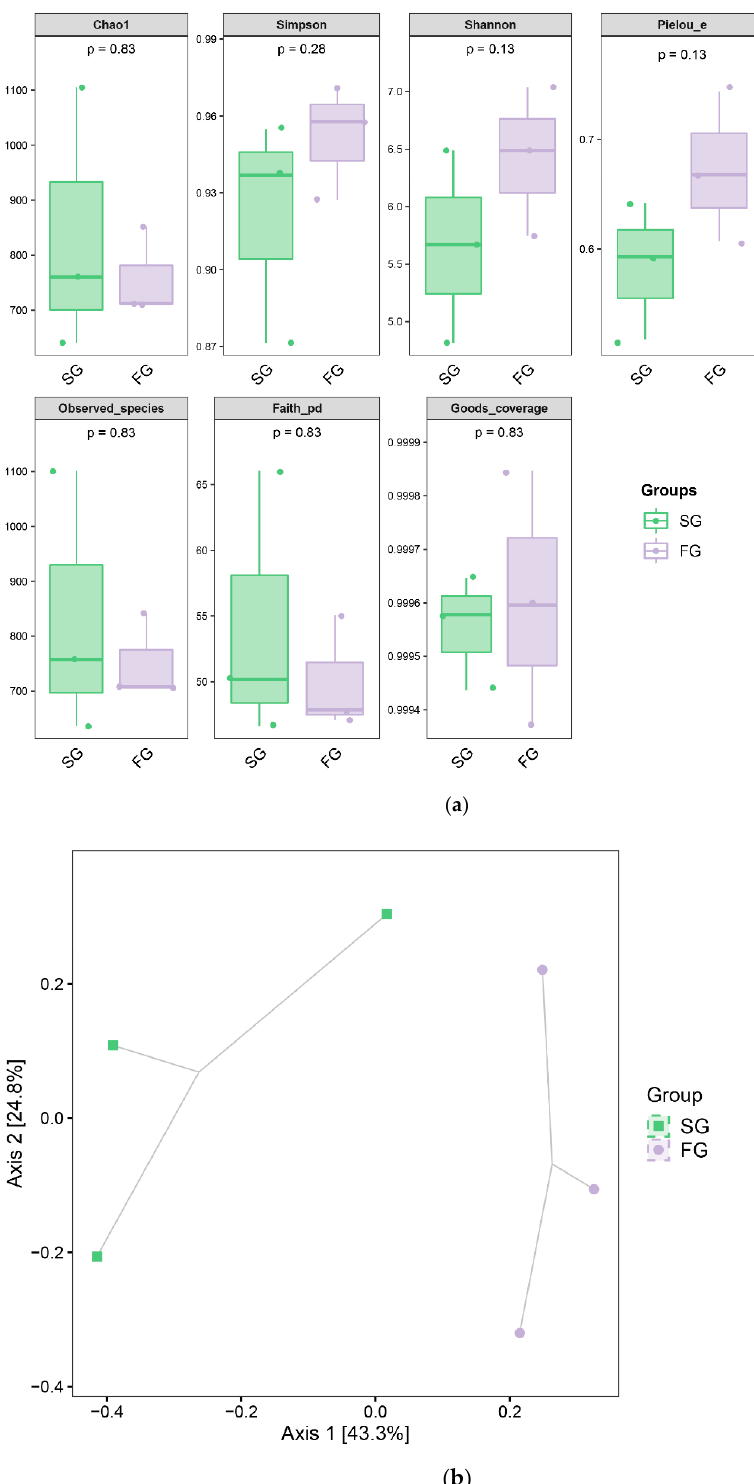
Figure 3. ( a ) Alpha diversity of the gut bacterial communities of the fast-growing (FG) and slow-growing (SG) groups of juvenile fish; ( b ) Bray–Curtis dissimilarity-based principal coordinate analysis (PCoA).